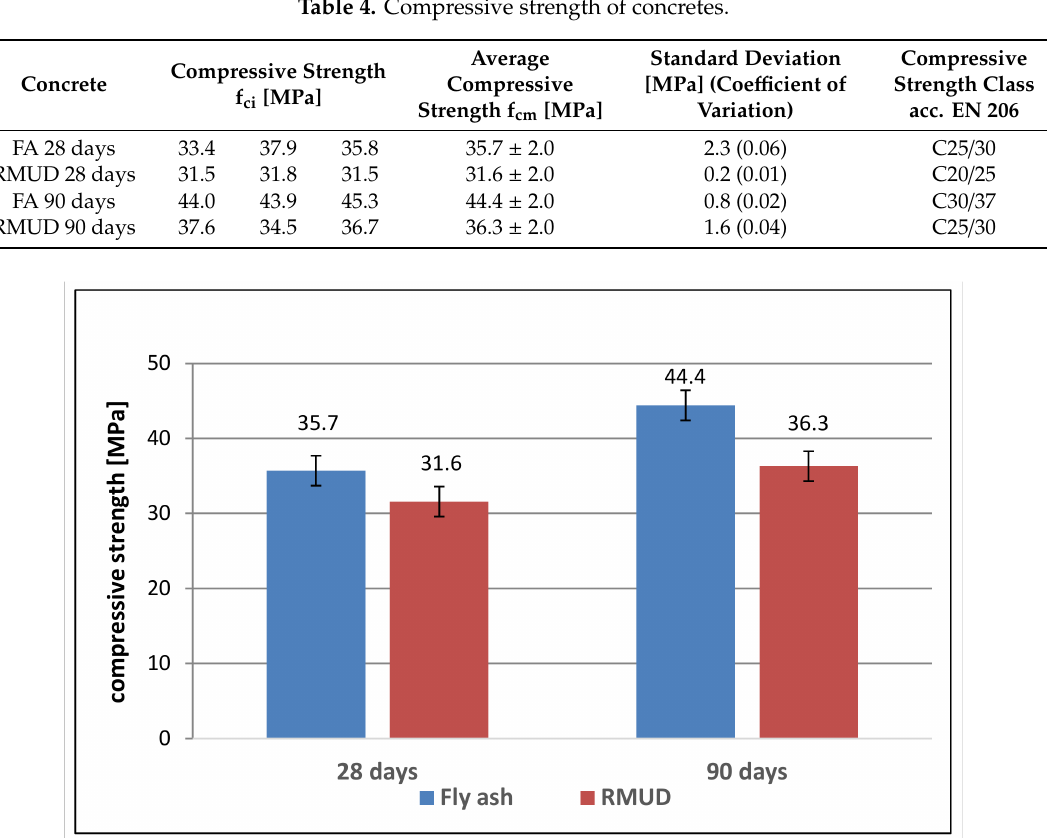
Figure 5. Compressive strength of